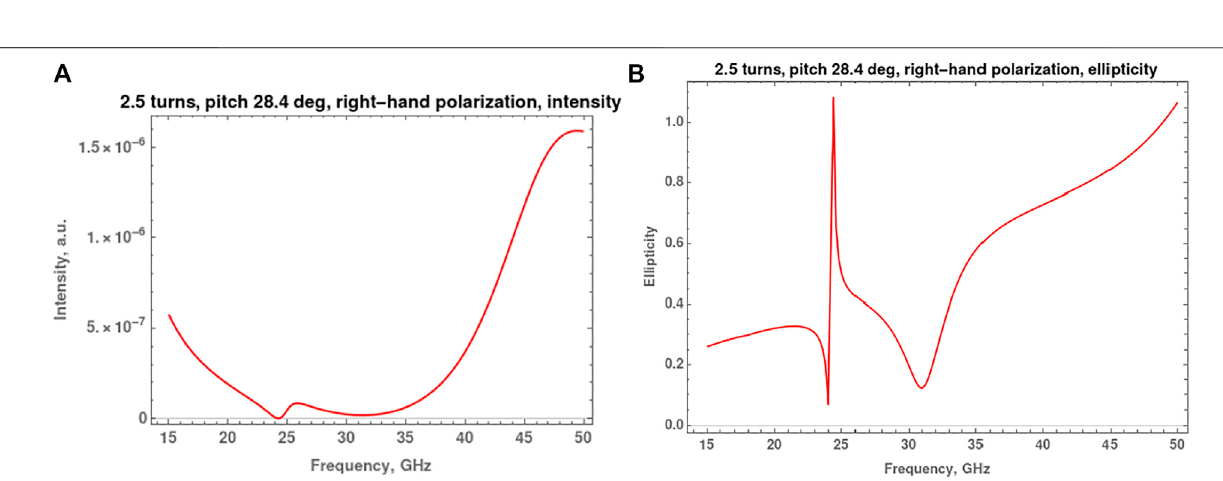
Frontiers in Nanotechnology |